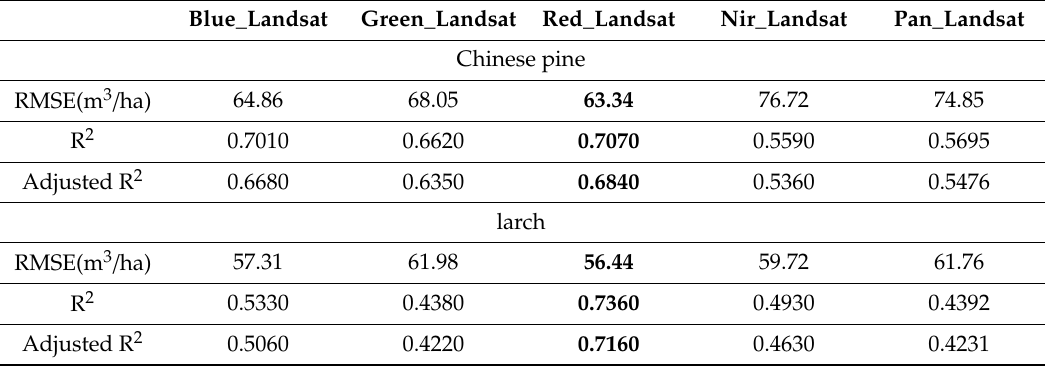
Table 4. Summary of RMSE, R 2 , and Adjusted R 2 for estimating GSV of Chinese Pine and Larch Plantations using five fusion datasets based on